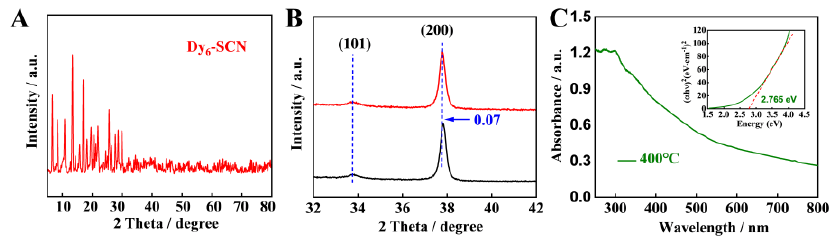
Figure 3. ( A ) X − ray diffraction (XRD) images of Dy 6 − SCN; ( B ) fine XRD patterns of Dy − OSCN/FTO electrode; ( C ) UV − vis DRS and Tauc plots of as-prepared Dy − OSCN/FTO electrode calcined at 400 °C.